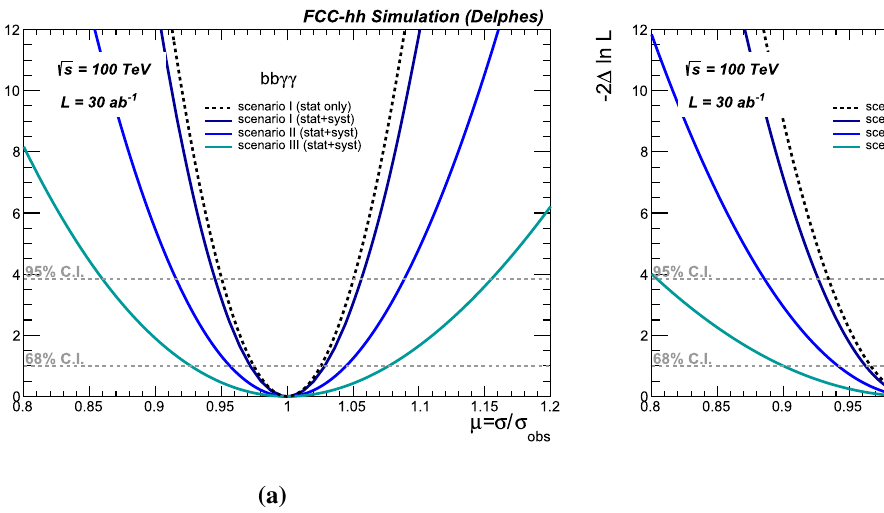
( a ) (b) Fig. 7 Expected negative log-Likelihood scan as a function the sig- different systematic uncertainty assumptions summarized in Table 3. nal strenth μ = σ/σ SM ( a ) and trilinear self-coupling modifier κ λ = The black dashed line shows the likelihood profile when only the sta- λ /λ SM ( b ) in the b ¯ b γγ channel. The various lines correspond to the tistical uncertainty is included under scenario 3 3